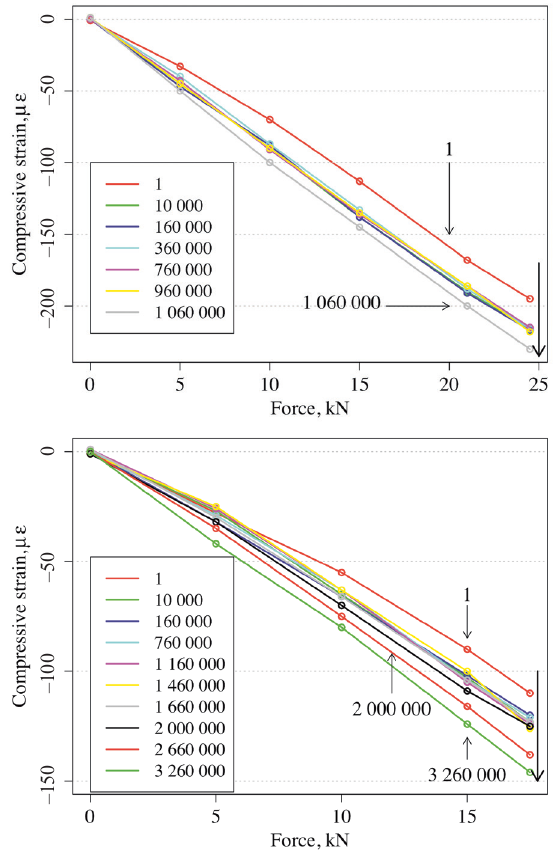
Figure 6. Strain variation in compression zone for beams a) F-3 and b)